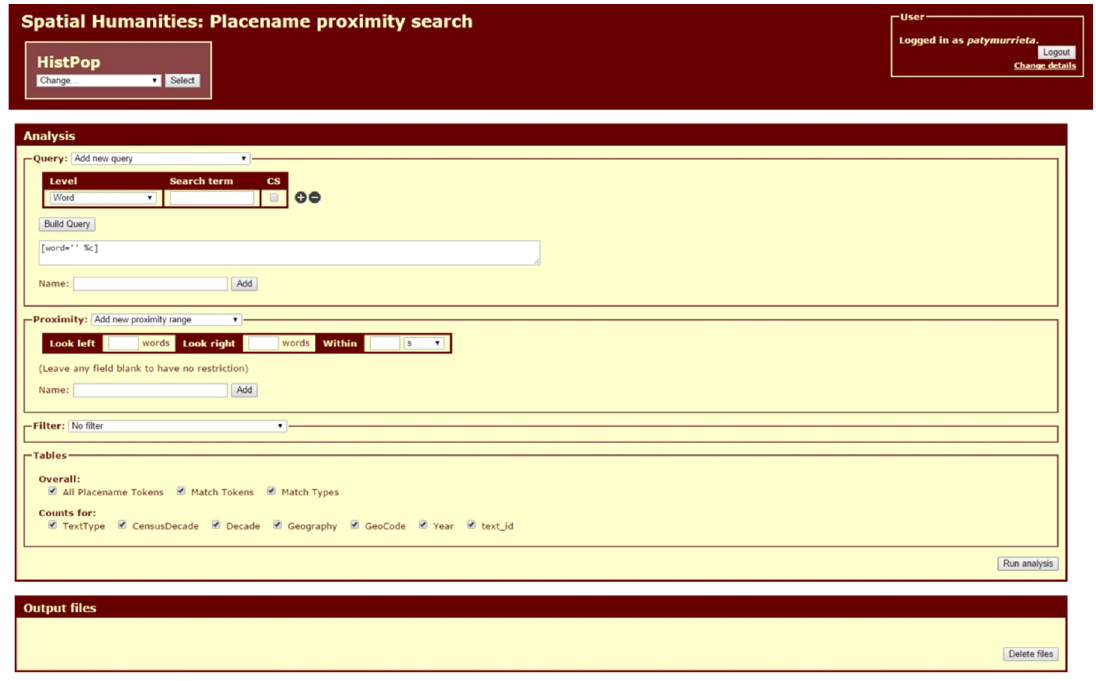
Figure 1: Interface screenshot of the Geographical Collocates